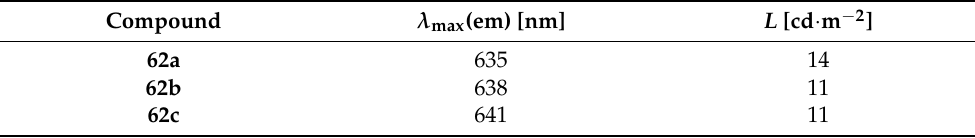
Figure 4. Examples of the basic structural units of polymers 62a – c , containing thieno[2,3- b ]thiophene applied in OLEDs. Table 3. Emissive properties and brightness of the OLEDs containing polymers 62a – c .